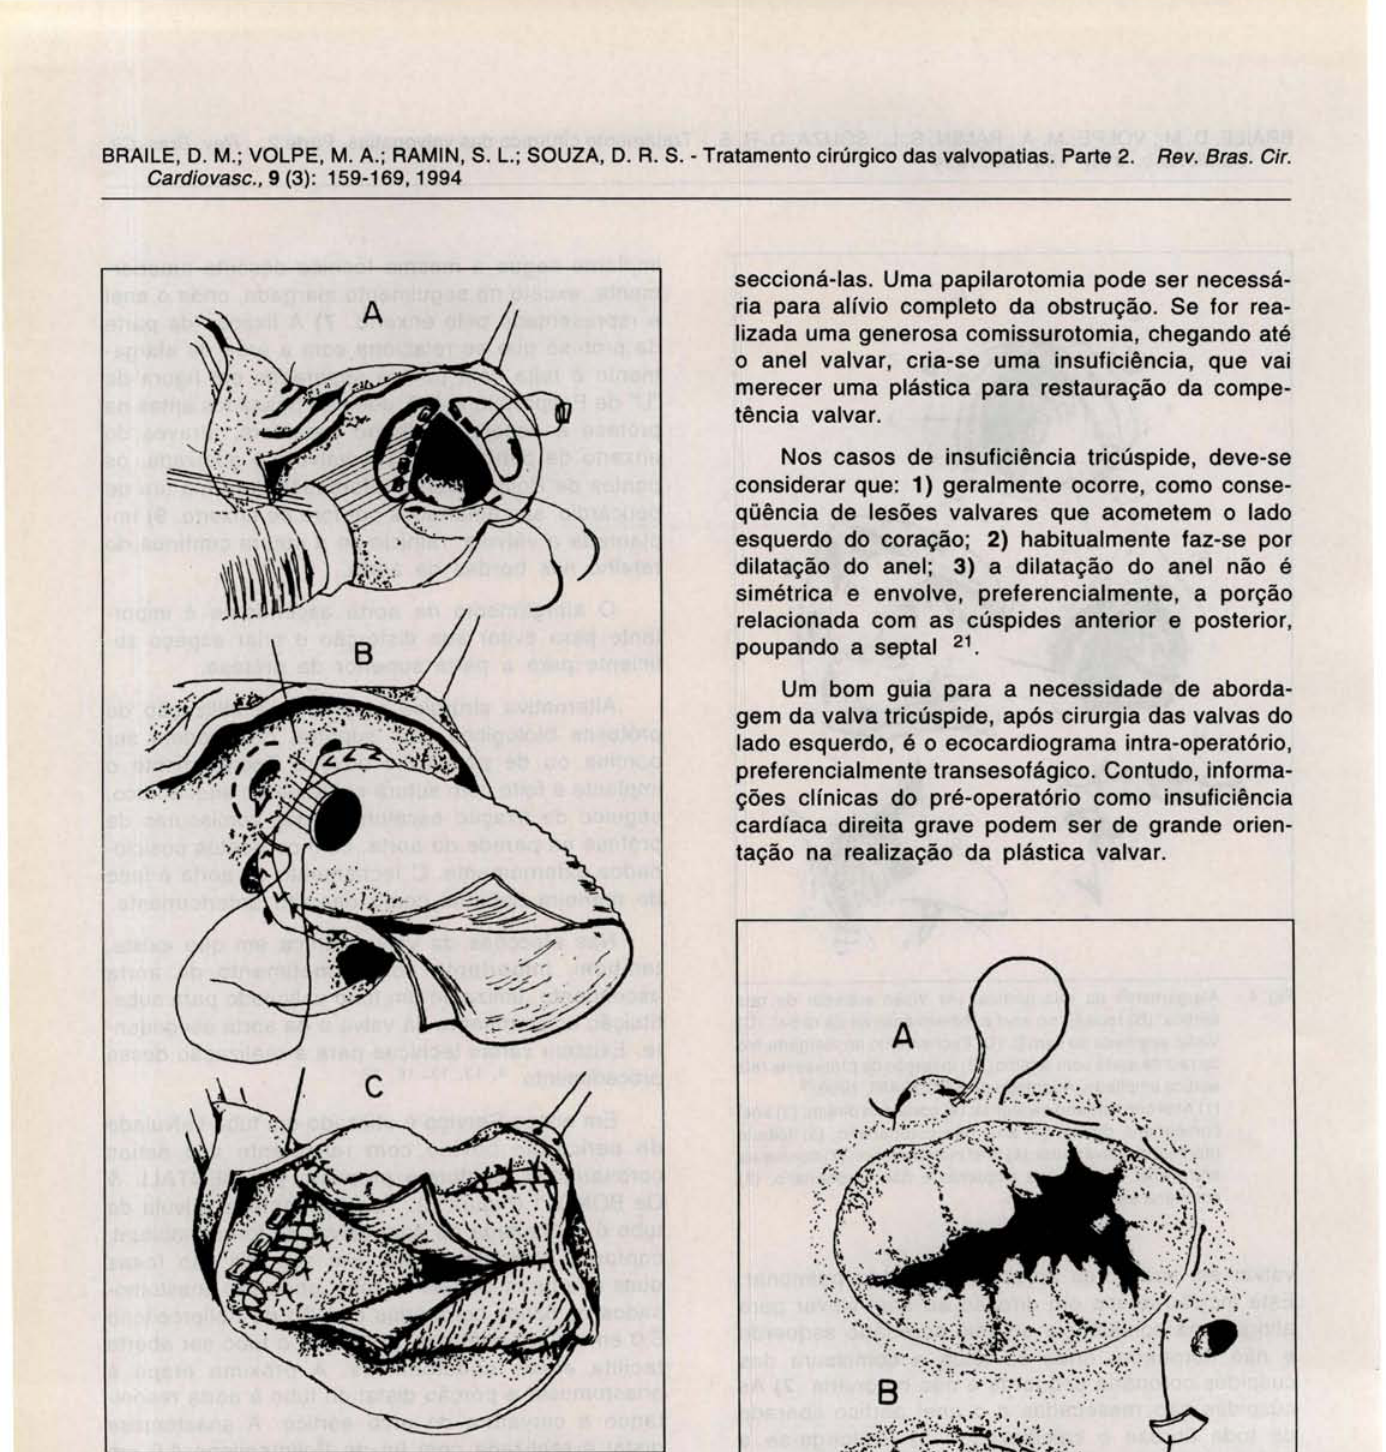
Fig. 5 - Substituição da raiz aórtica por tubo valvulado de pericárdio bovino. (A) Sutura do tubo valvulado no anel aórtico. (8) Anastomose do óstio coronariano na prótese. (e) Sutura da porção distai do tubo. Adaptado de KHONSARI, 1990 2